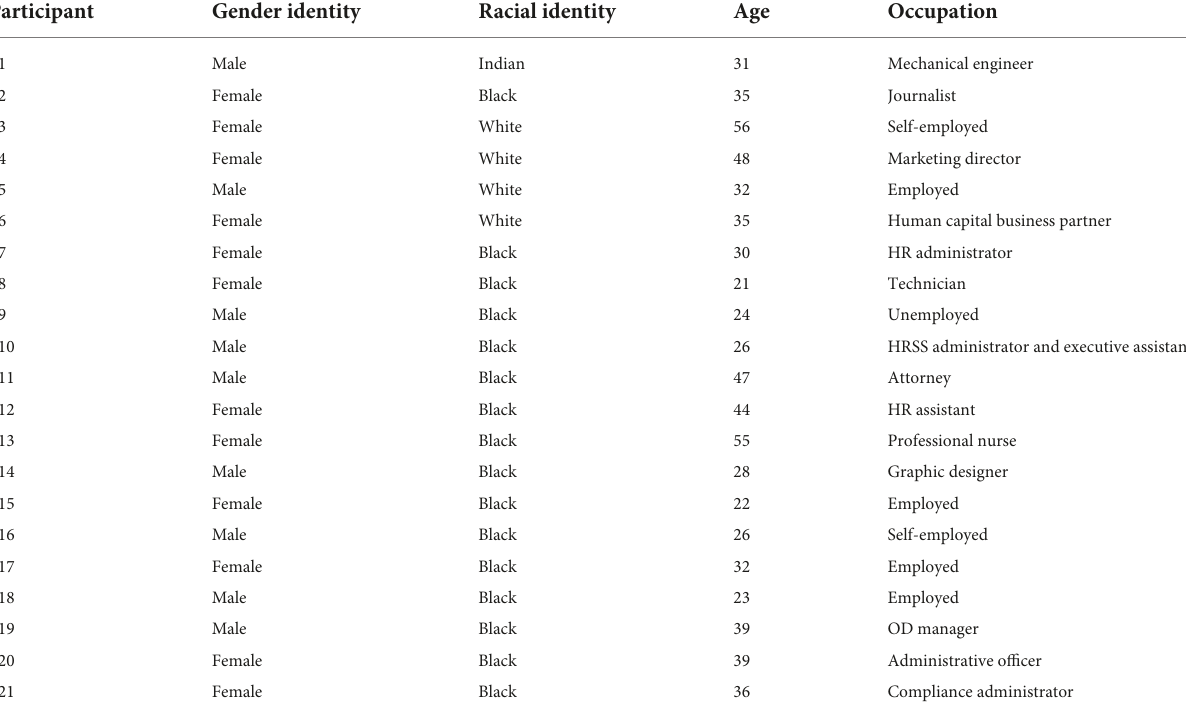
TABLE 1 Characteristics of participants.